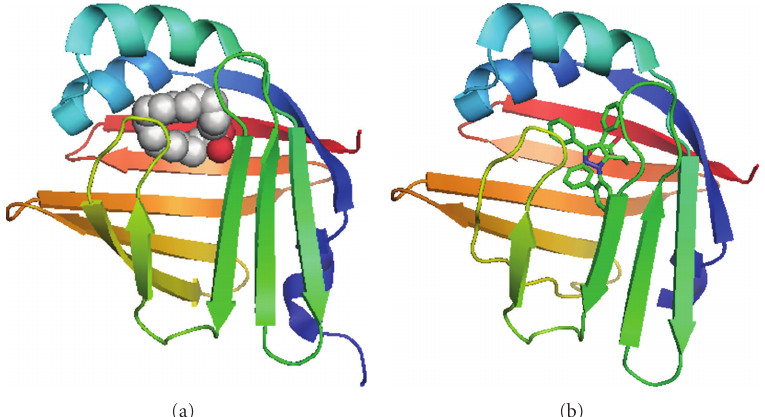
Figure 2: FABP4 bound with a fatty acid or a small molecule inhibitor. (a) Human FABP4 binds to an endogenous fatty acid, palmitic acid, as a twisted U-shaped entity in the binding pocket (PDB code: 2hnx). (b) Human FABP4 crystallized in complex with BMS309403, a synthetic FABP4 inhibitor, is shown (PDB code: 2nnq). The molecule occupies the internal binding pocket of FABP4 and competitively inhibits binding of endogenous fatty acids. The figures were created using